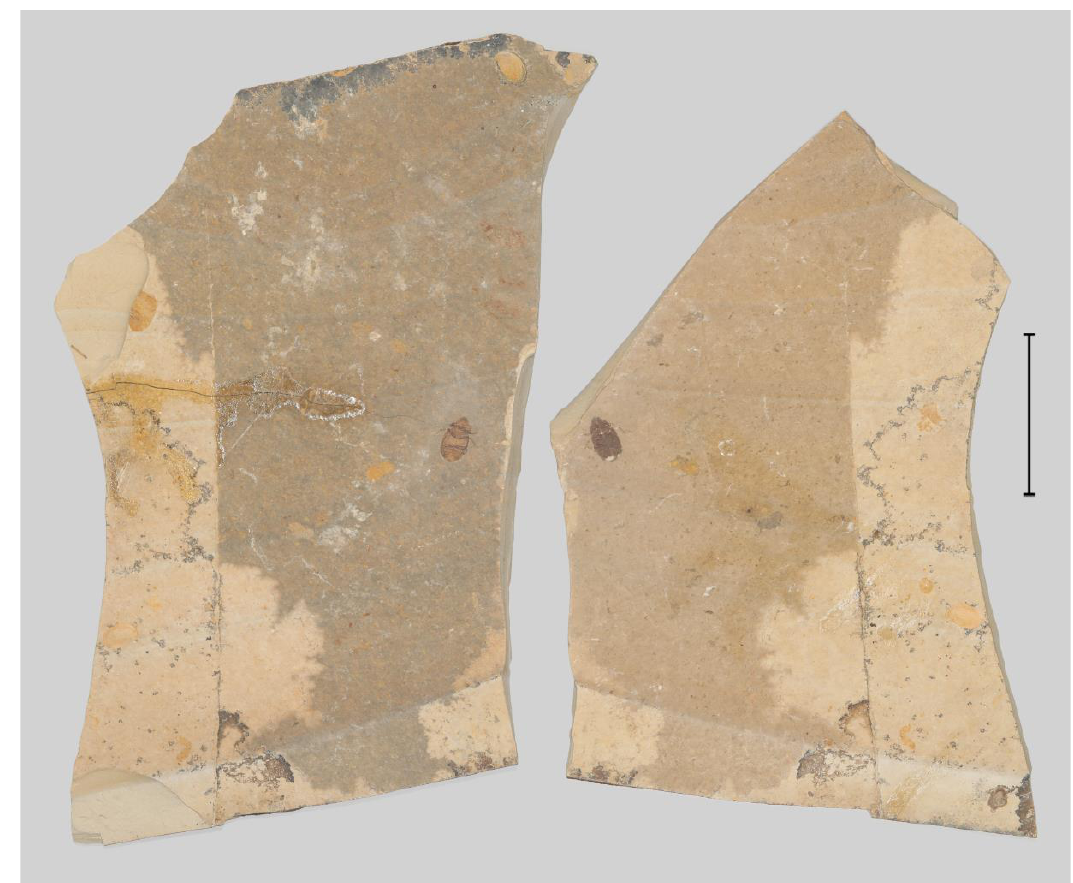
Figure 1. Fossil specimen of Prolucanus beipiaoensis gen. et sp. nov. (holotype, NIGP 176633). Scale bars = 5 cm.